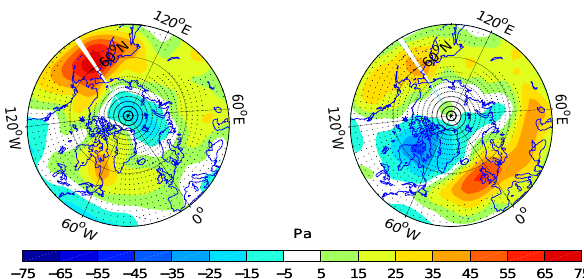
Fig. 16. composite of annual mean anomalous sea level pressure in phase with the volcanic eruptions of the period 1100–1300 A.D. (left) and with the volcanic eruptions post-1400 A.D.